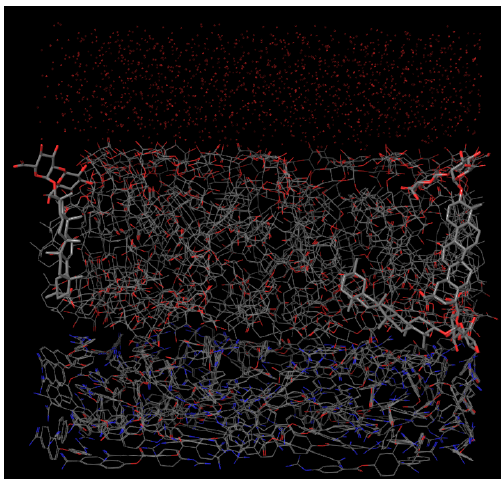
Figure 2. Result of single layer modeling of DB13751 between water and nafamostat performed by using the Schrödinger software. The result shows that a single layer of DB13751 was formed with some molecules of DB13751 arranged vertically with their hydrophilic heads directed to water (top) and nafamostat